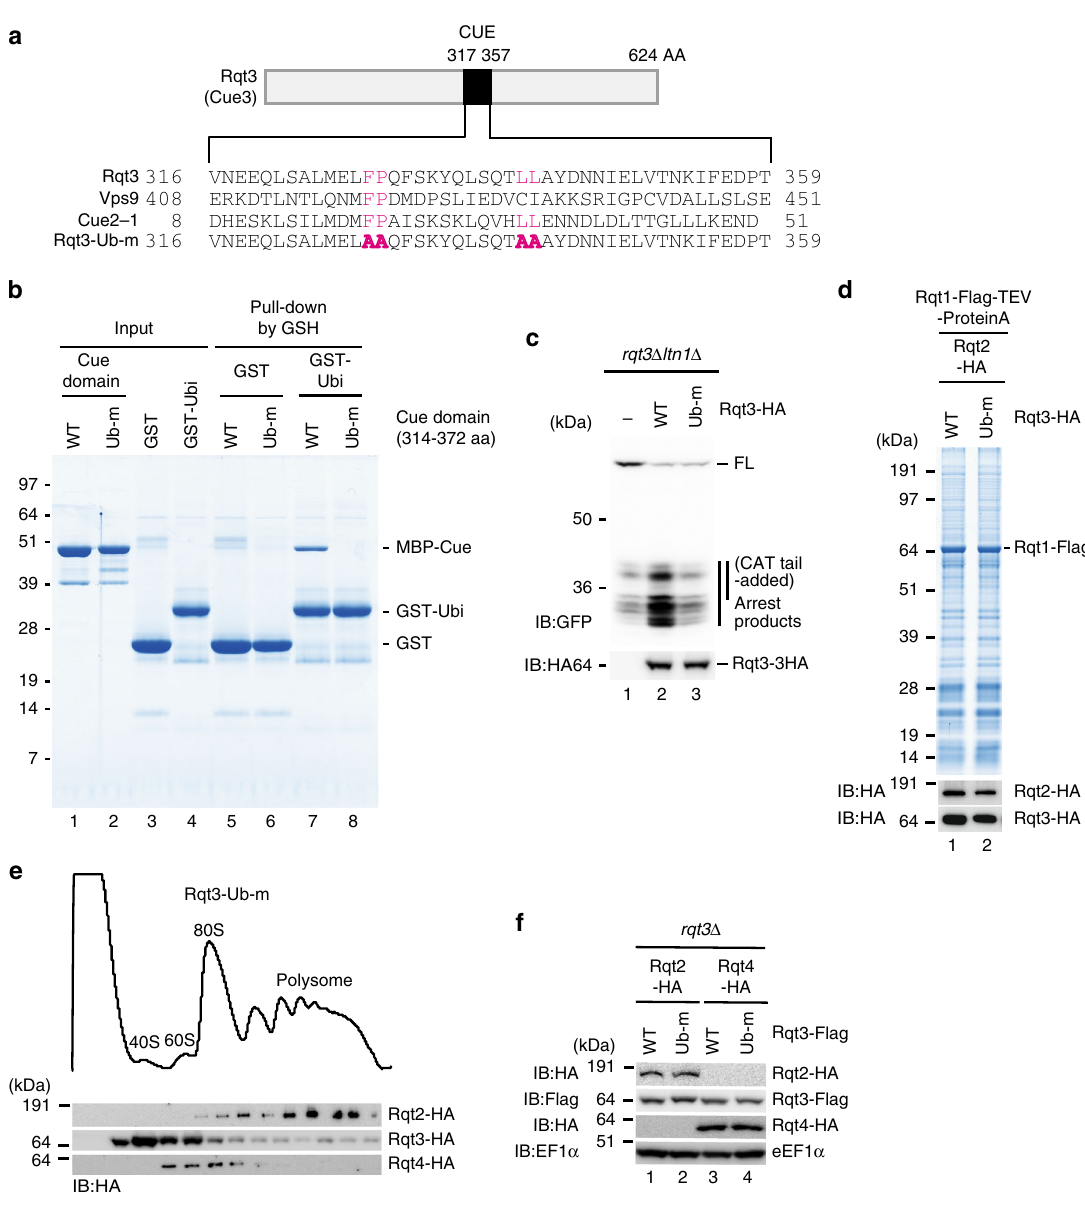
Fig. 3 The mutations of Rqt3 in the residues crucial for the ubiquitin-binding domain diminished RQC. a Alignment of the conserved residues in the CUE domains of Rqt3, Vps9, and Cue2. The mutated residues in Rqt3-Ub-m were shown in red . b CUE domain of Rqt3 interacted directly with ubiquitin, and it was abolished by Ub-m mutations. c The mutations of Rqt3 in the residues crucial for the ubiquitin-binding domain diminished RQC. d The mutation in the ubiquitin binding of Rqt3 is dispensable for the association of Rqt2-4 in Rqt1-ribosome complex. e The distribution of Rqt2-4 proteins in polysome pro fi les of Rqt3-Ub-m mutant. f The expression levels of endogenously HA-tagged Rqt2 and Rqt4, Flag-tagged Rqt3 and Rqt3-Ub-m proteins in Rqt3-Ub-m mutant